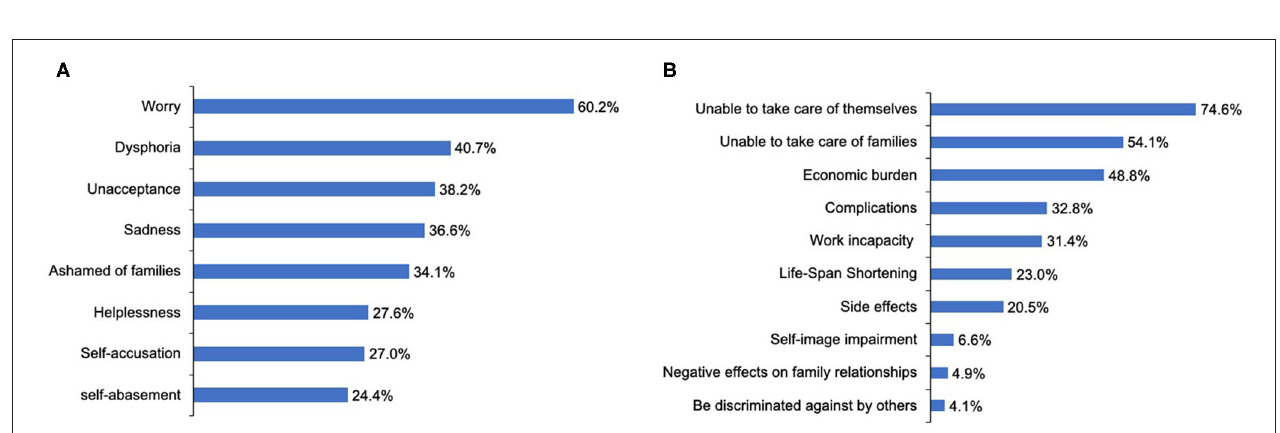
FIGURE 5 | Emotional status of patients with NMOSD and their concerns regarding this disorder. (A) The negative emotions experiencing by the patients with NMOSD. (B) Patients’ concerns about